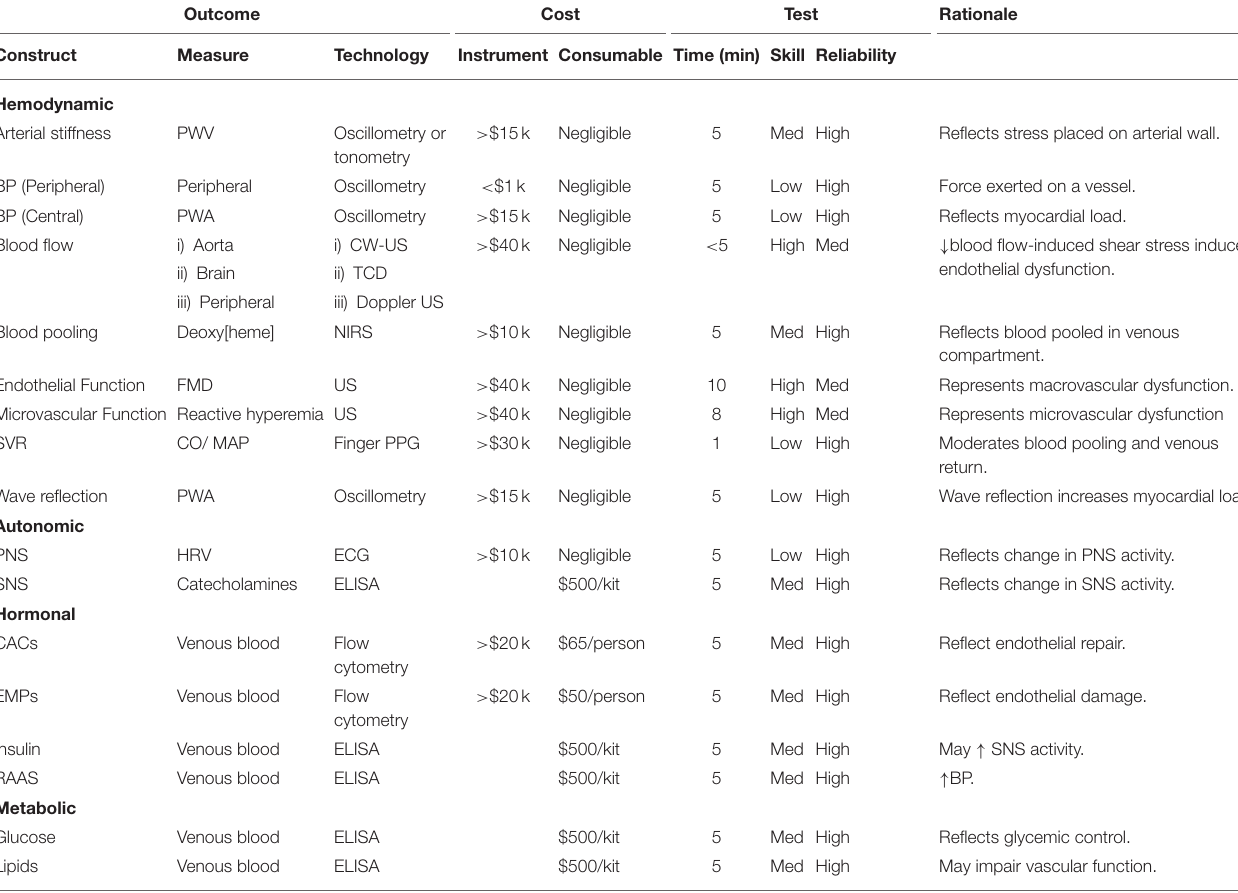
TABLE 2 | Research toolbox for investigating the effect of acute sitting exposure on the cardiovascular system. Outcome Cost Test Rationale